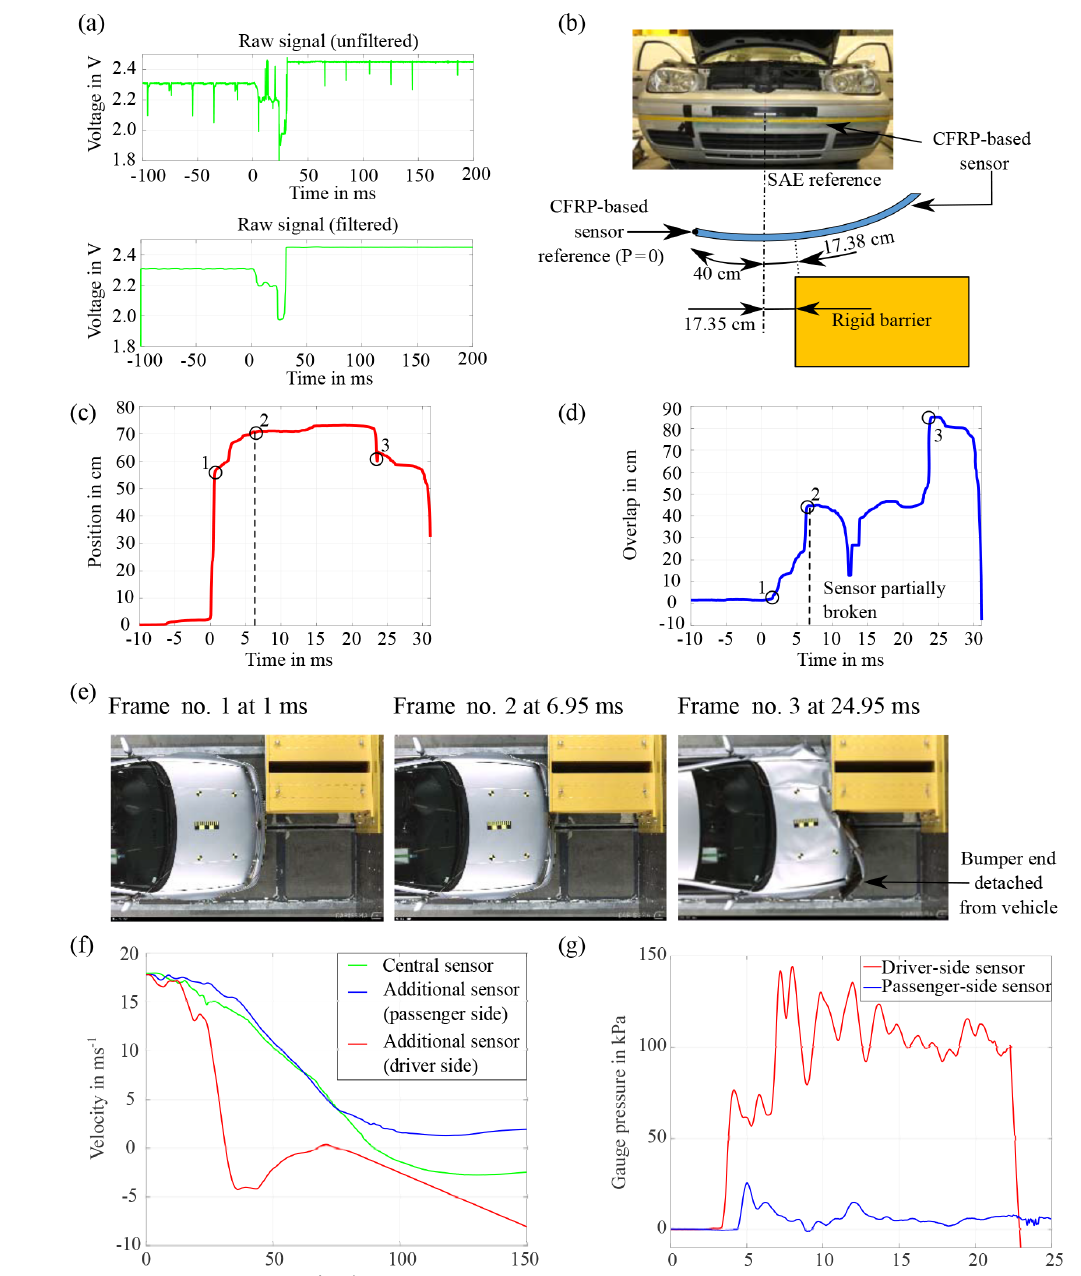
Figure 9. Results from crash test: (a) raw and filtered signal, (b) sensor and vehicle reference system, (c) position signal, (d) overlap signal, (e) important events during crash, (f) velocity signal calculated from acceleration sensor, and (g) signals from pressure-hose sensor (pressure measured is gauge pressure, i.e., reference is atmospheric